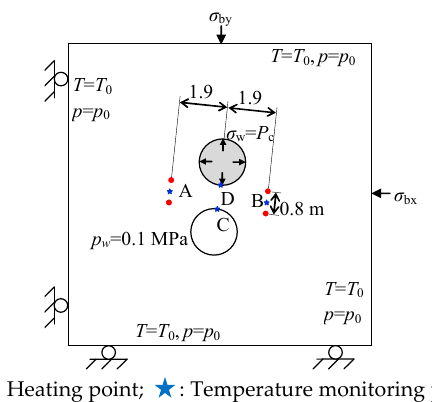
Figure 6. Excavation-induced tangential stress at Point C of the pillar: ( a ) Monitoring result [20]; ( b ) simulated result with different boundary stress σ by .